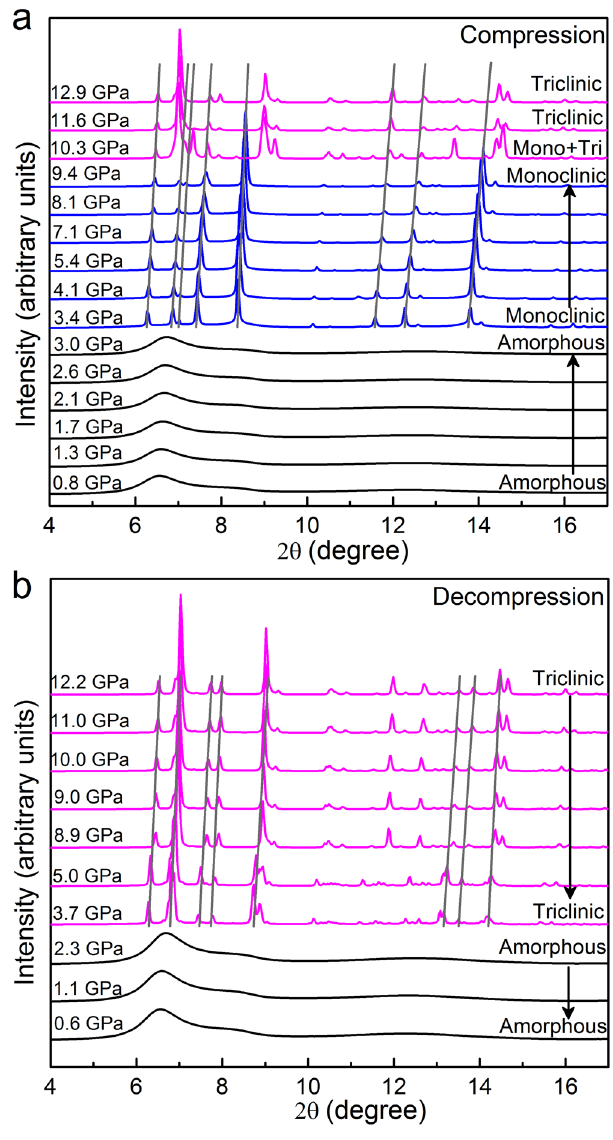
Figure 1. In-situ XRD patterns of Ga 85.8 In 14.2 eutectic alloy upon ( a ) compression and ( b ) decompression in the pressure range of 0–13 GPa at ambient temperature. The light lines trace the change of Bragg peaks with